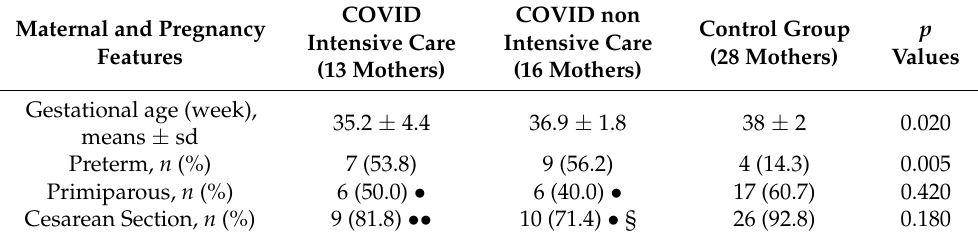
Table 1. Maternal and pregnancy